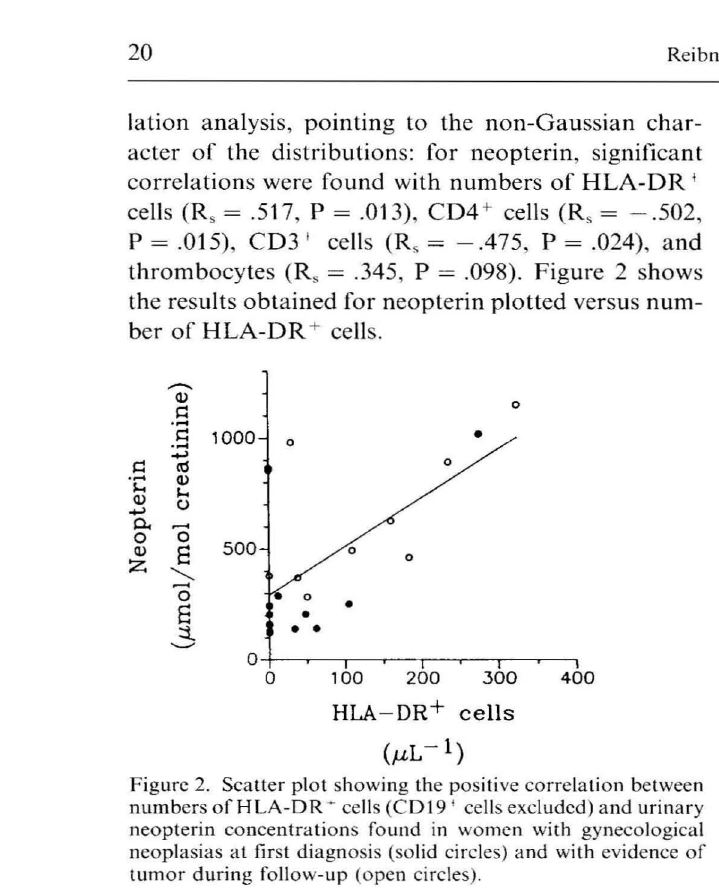
Figure 2. Scalter plot showing the positive correlation between numbers of HLA-DR ~ cells (CD 19 ' cells excluded) and urinary neopterin concentrations found in women with gynecological neoplasias at first diagnosis (solid circles) and with evidence of tumor during follow-up (open